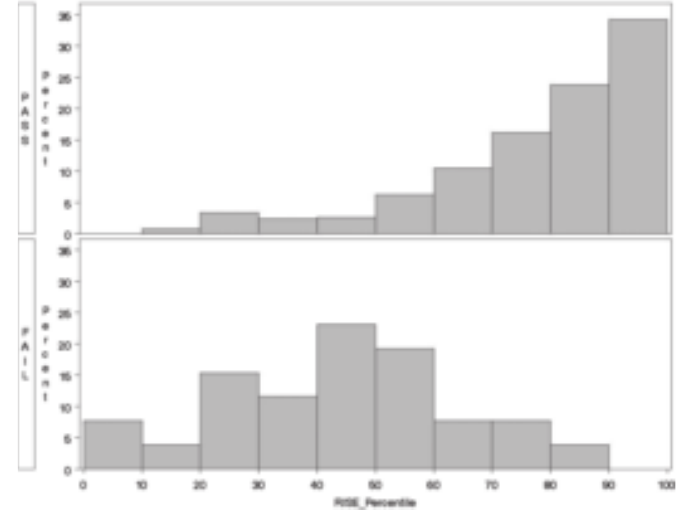
Figure 3. The American Osteopathic Board of Emergency Medicine (AOBEM) Part 1 fail and pass rates for each decile score on the Resident In-Service Examination